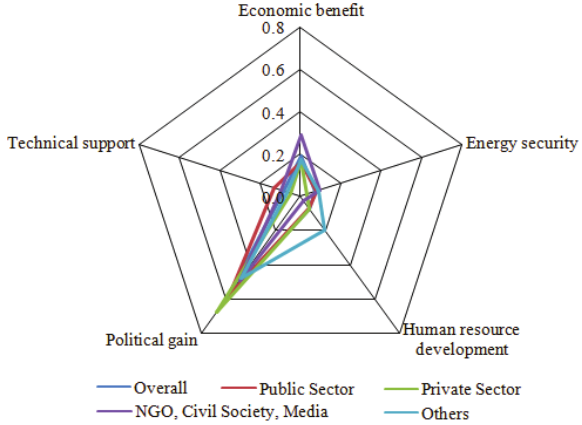
Figure 7. Cumulative and occupation-wise responses to ques - tion A7: “What do you think is the main objective behind Ban - gladesh’s bilateral nuclear collaboration with India?”.